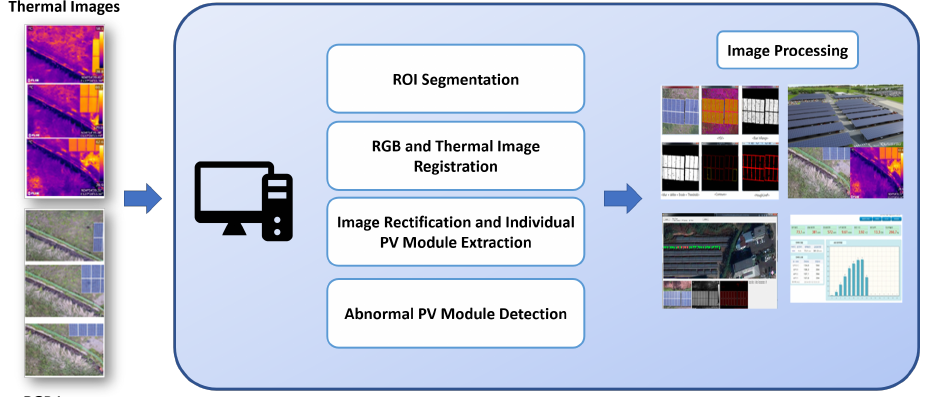
Figure 8. Block diagram for thermal image